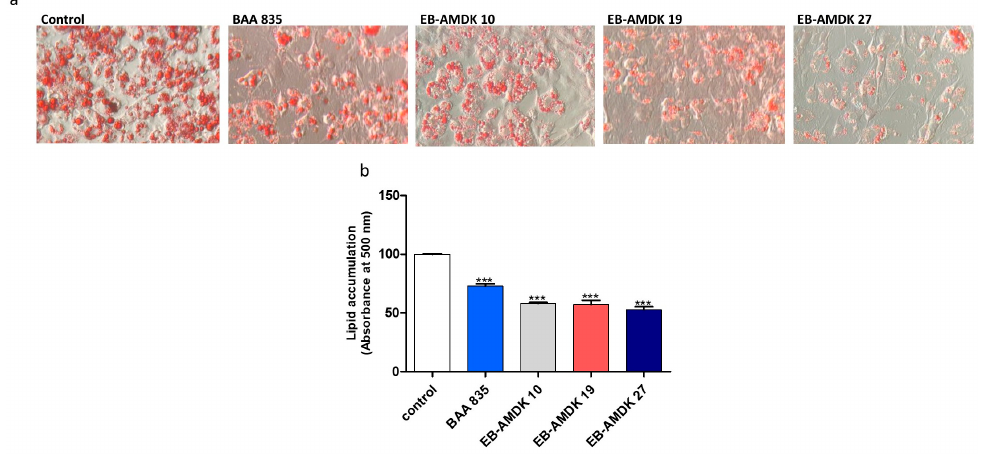
Figure 1. Effects of Akkermansia muciniphila strains on lipid accumulation in 3T3-L1 adipocytes. ( a ) After differentiation, the intracellular lipid droplets of adipocytes in different experimental groups were visualized under a microscope at 200 × magnification upon staining of the cells with Oil Red O. ( b ) Intracellular deposition of the lipids was measured after extraction and reading the absorbance at 500 nm. The data are presented as the mean ± SEM. *** p < 0.001 versus the control group.